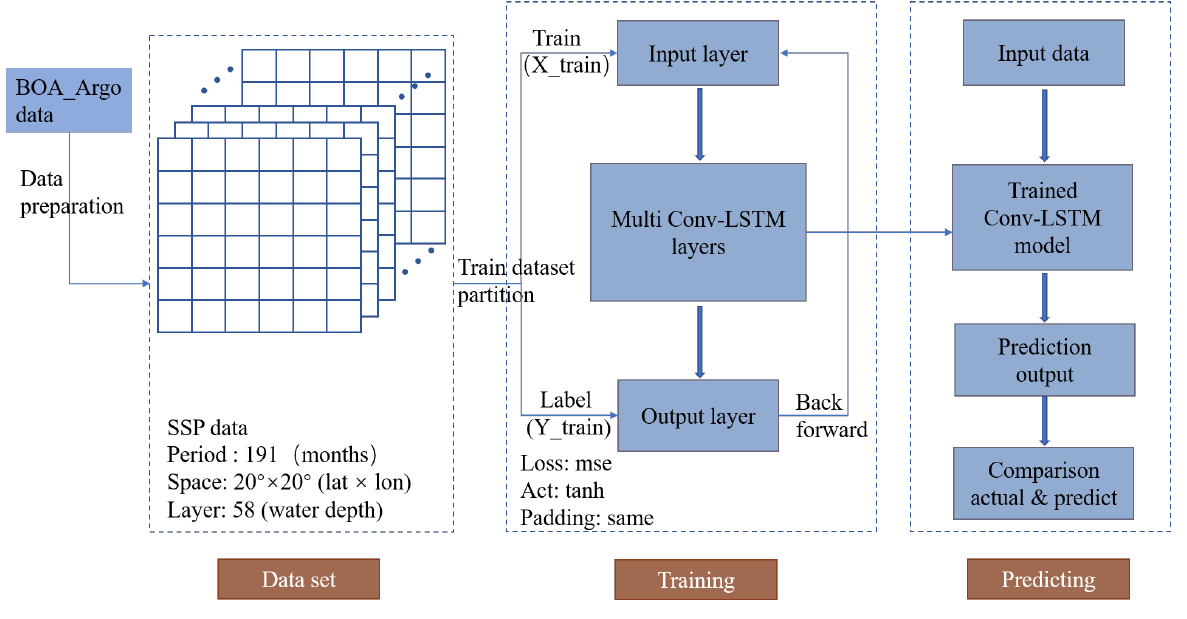
Figure 7. Workflow of the Conv-LSTM